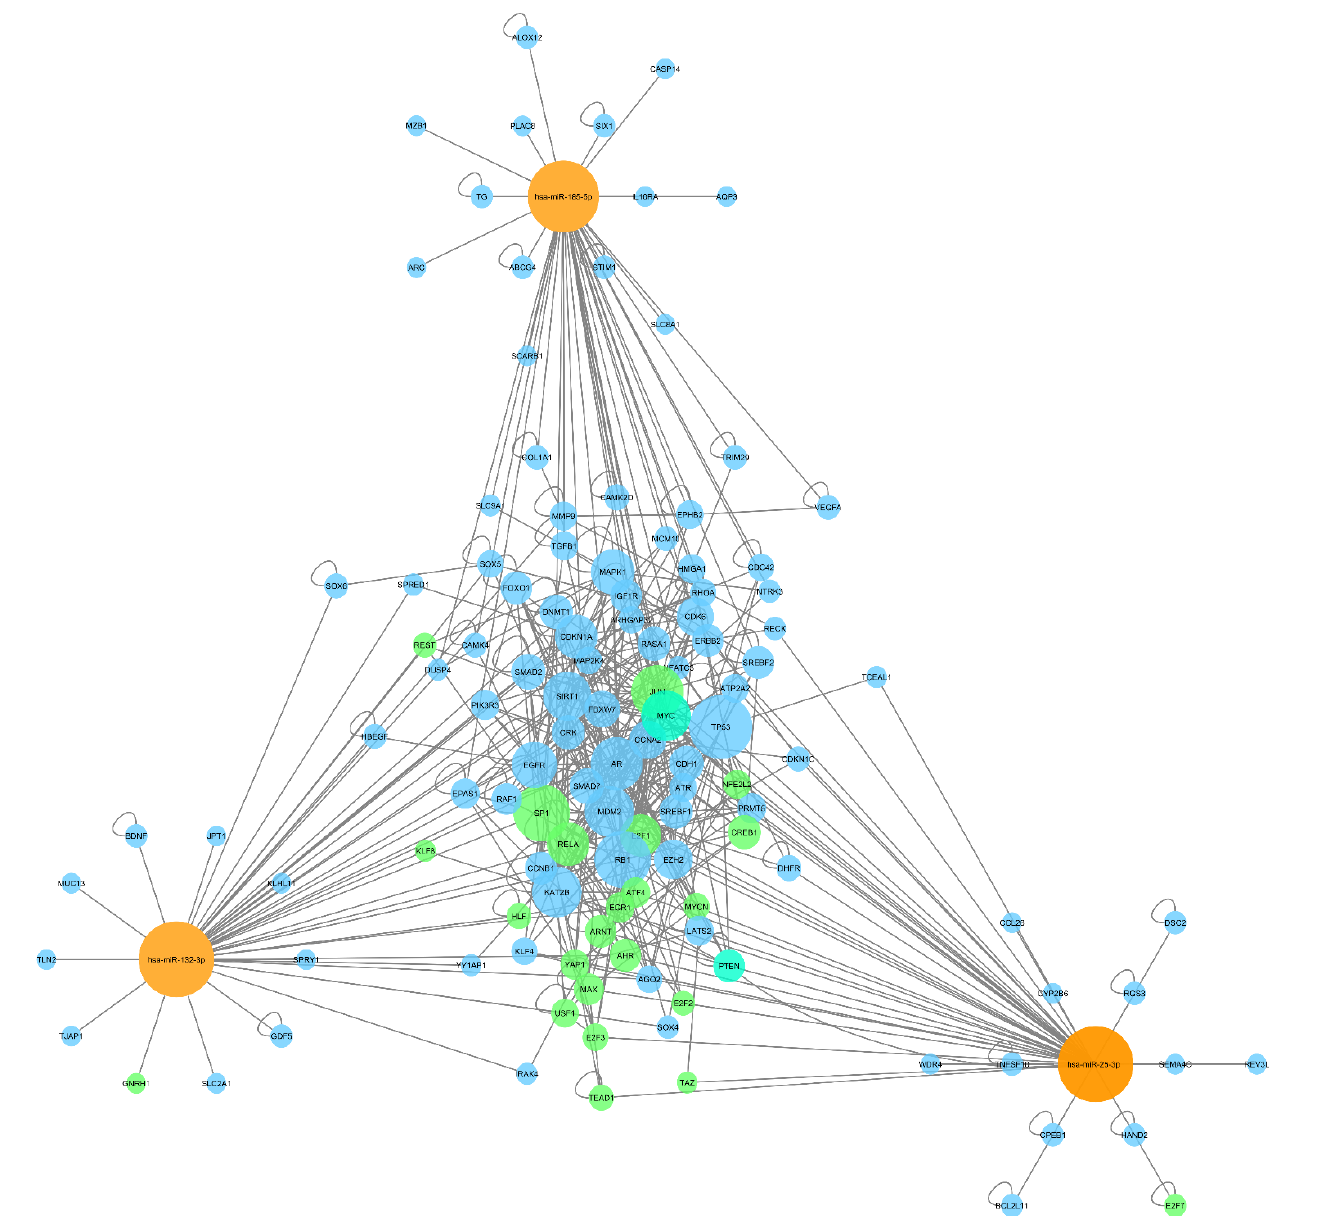
Figure 3. Interaction network of deregulated miRNAs including their target genes and transcription factors. Orange: miRNA. Blue: target gene. Green: transcription factors. Turquoise: transcription factor and target gene. Interactions between miRNA nodes and gene nodes indicate miRNA dependent repression of mRNA translation of the indicated gene. Interactions between genes indicate molecular interactions of their protein products. Node size indicates its degree (number of interactions).